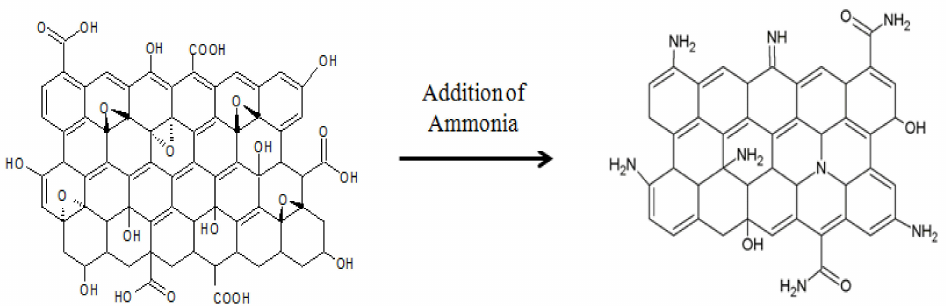
Figure 1. Structure of aminated graphene oxide after reaction.